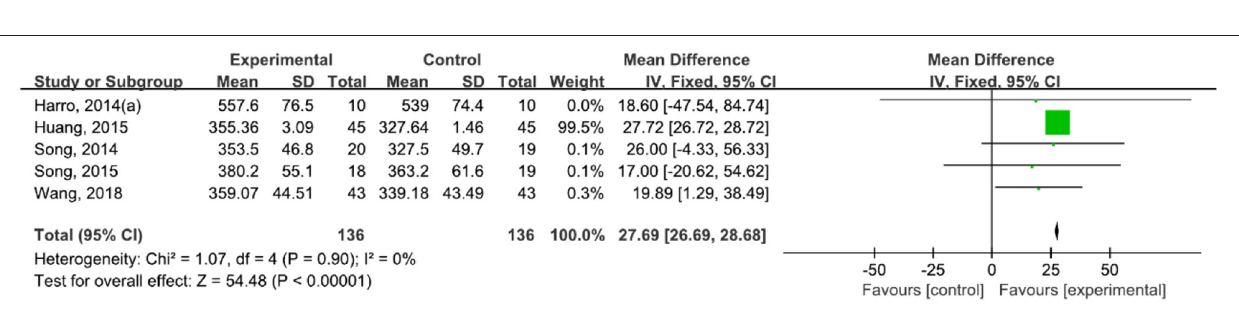
FIGURE 7 | Forest plot showing MD (with 95% CI) for stride length of the included studies comparing the experimental and control groups.